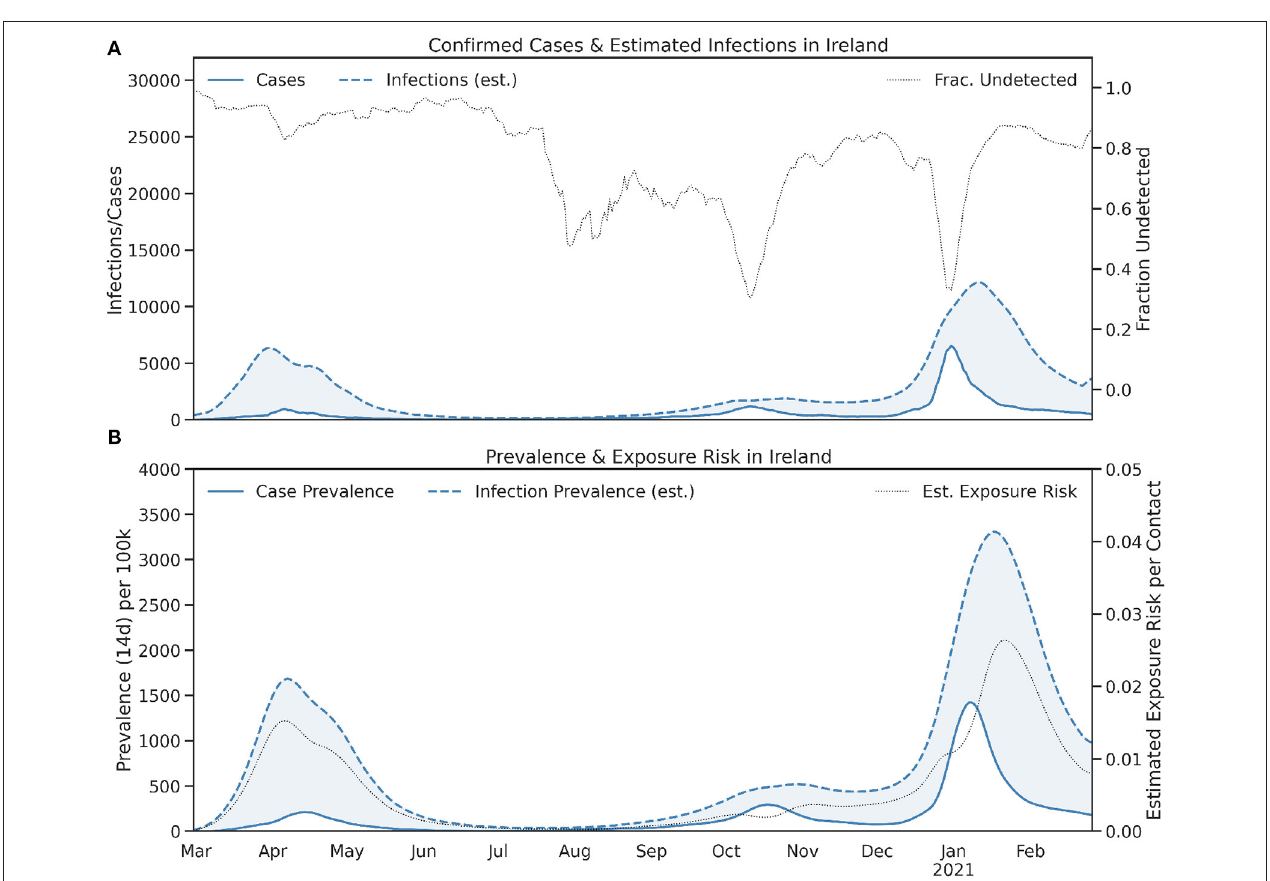
FIGURE 1 | The (A) daily and (B) 14-day totals (prevalence) of confirmed cases and estimated infections in Ireland. In (A) the fraction of undetected infections and in (B) the estimated exposure risk, are also